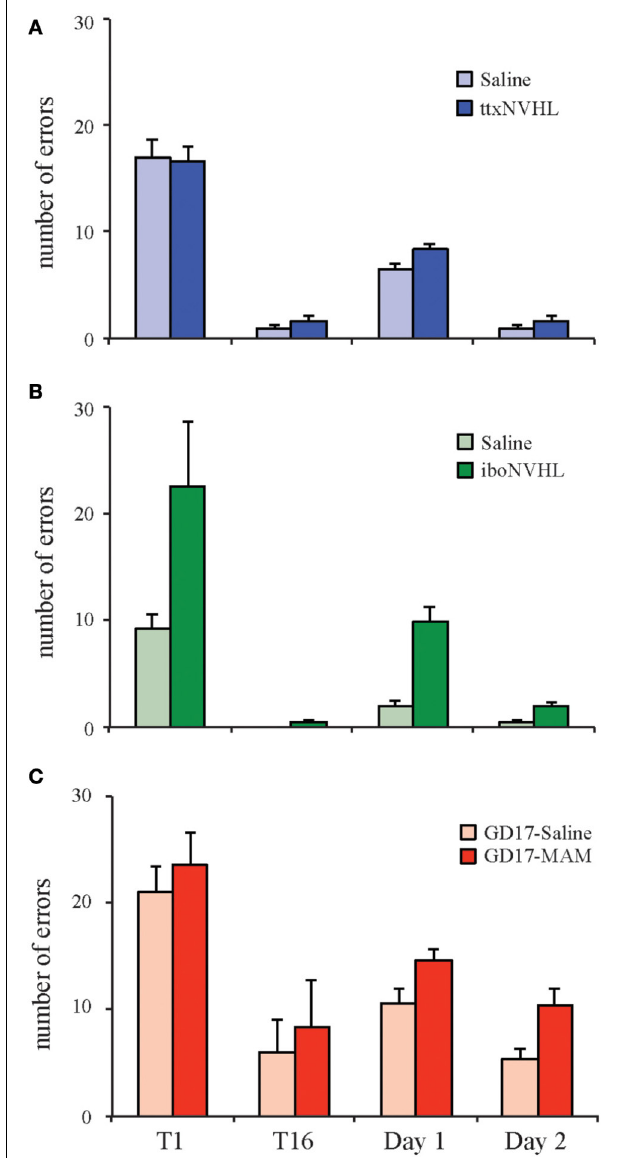
FIGURE 3 | Neurodevelopmental insults differently affect cognitive ability. Three animal models of schizophrenia are generated in the Long Evans strain of rats and are being used to test the neural discoordination hypothesis. Cognitive control was tested using the two-frame active place avoidance task. Generation of the ttxNVHL and iboNVHL is as follows: on postnatal day 7, male pups were anesthetized by hypothermia and bilateral injections of TTX (30ng/ µ L; 0.3 µ L/hemisphere), ibotenic acid (10 µ g/ µ L; 0.3 µ L/hemisphere), or an equal volume of saline was injected into each ventral hippocampus. To generate MAM animals, timed pregnant females were given intraperitoneal injection of MAM (26mg/kg) or an equal volume of saline at gestational day 17 (GD17). (A) ttxNVHL animals do not have cognitive deficits in the two-frame active place avoidance task and are predicted to have normal neural coordination. (B) Adult iboNVHL animals have deficits in the two-frame active place avoidance task and also have altered interhippocampal neural coordination (Lee et al., 2012). (C) GD17-MAM animals have difficulty performing the two-frame active place avoidance task and are predicted to have poor neural coordination. Data are presented as average ±